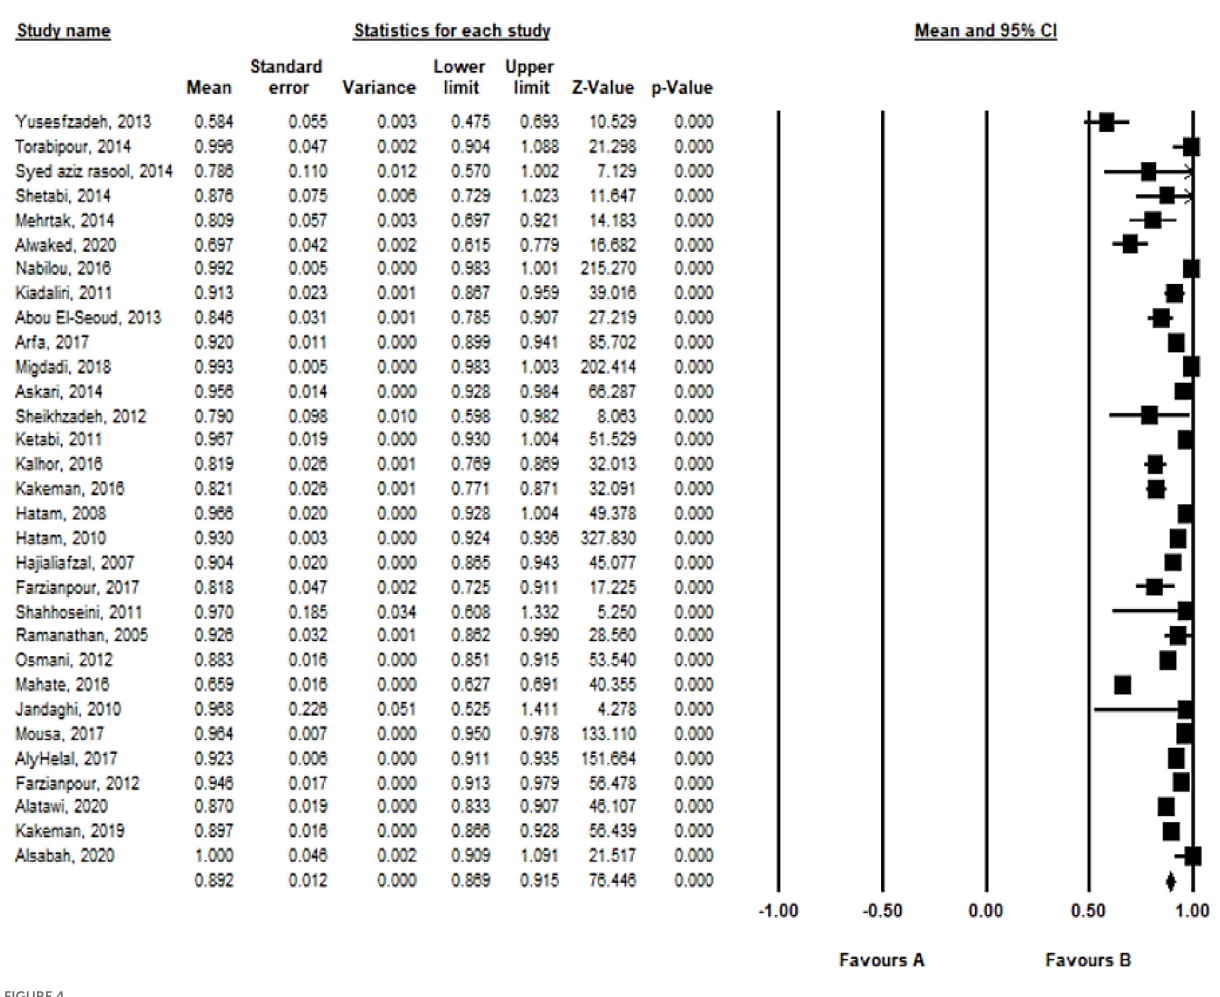
FIGURE4 Mean and standard deviation of TE with the VRS model in included studies based on the random-effects